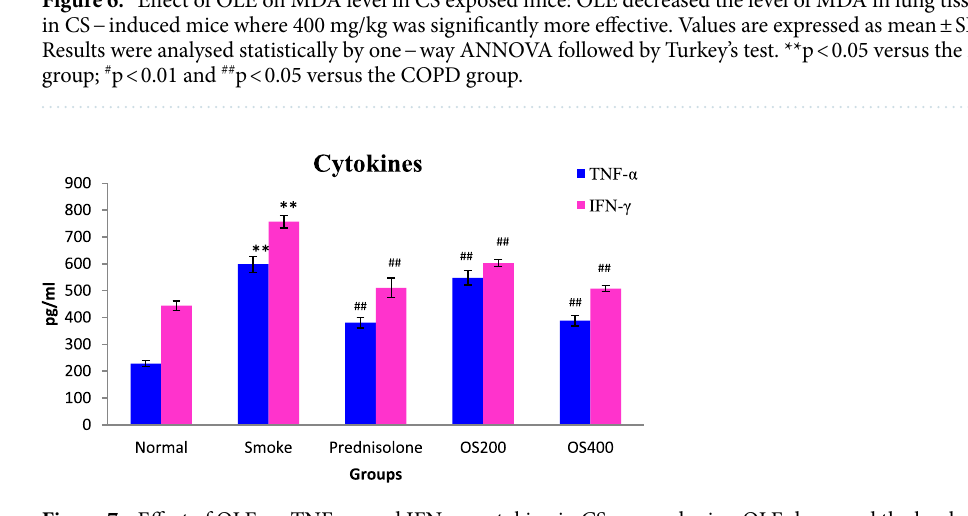
Figure 7. Effect of OLE on TNF − α and IFN − γ cytokine in CS exposed mice: OLE decreased the level of TNF − α and enhanced the level of IFN − γ in CS − induced mice. Results were analyzed statistically by one way ANNOVA followed by Turkey’s test. Values are expressed as mean ± SEM. **p < 0.05 versus the normal group; ## p < 0.05 versus the COPD